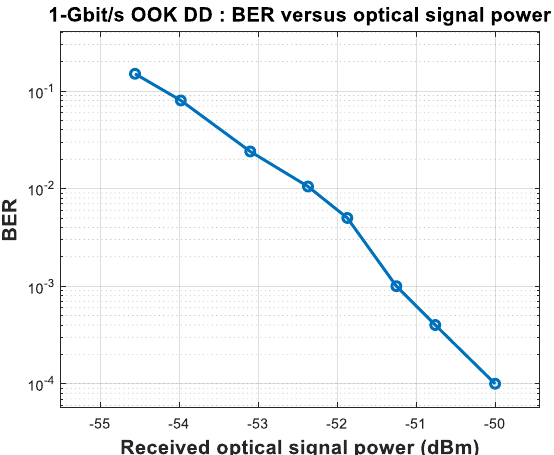
Figure 2. Curve between BER and received signal power of OOK DD with a communication rate of 1 Gbit/s.